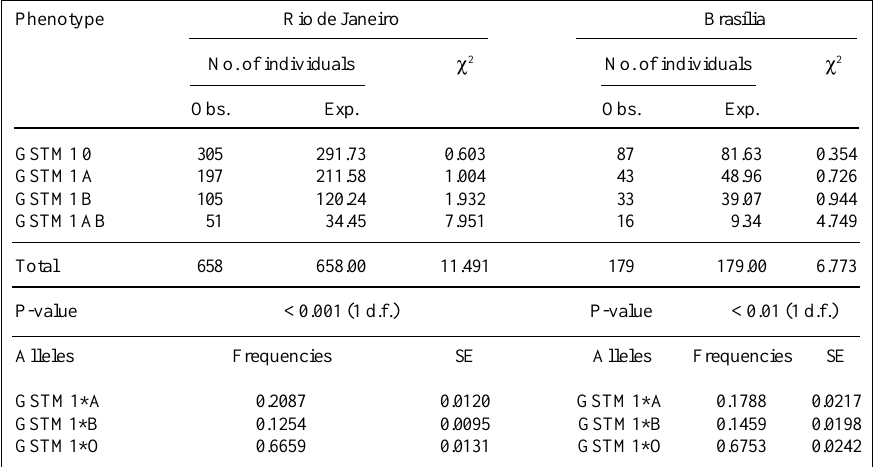
Table I - Test for Hardy-Weinberg equilibrium of two Brazilian populations (Rio de Janeiro and Brasília).